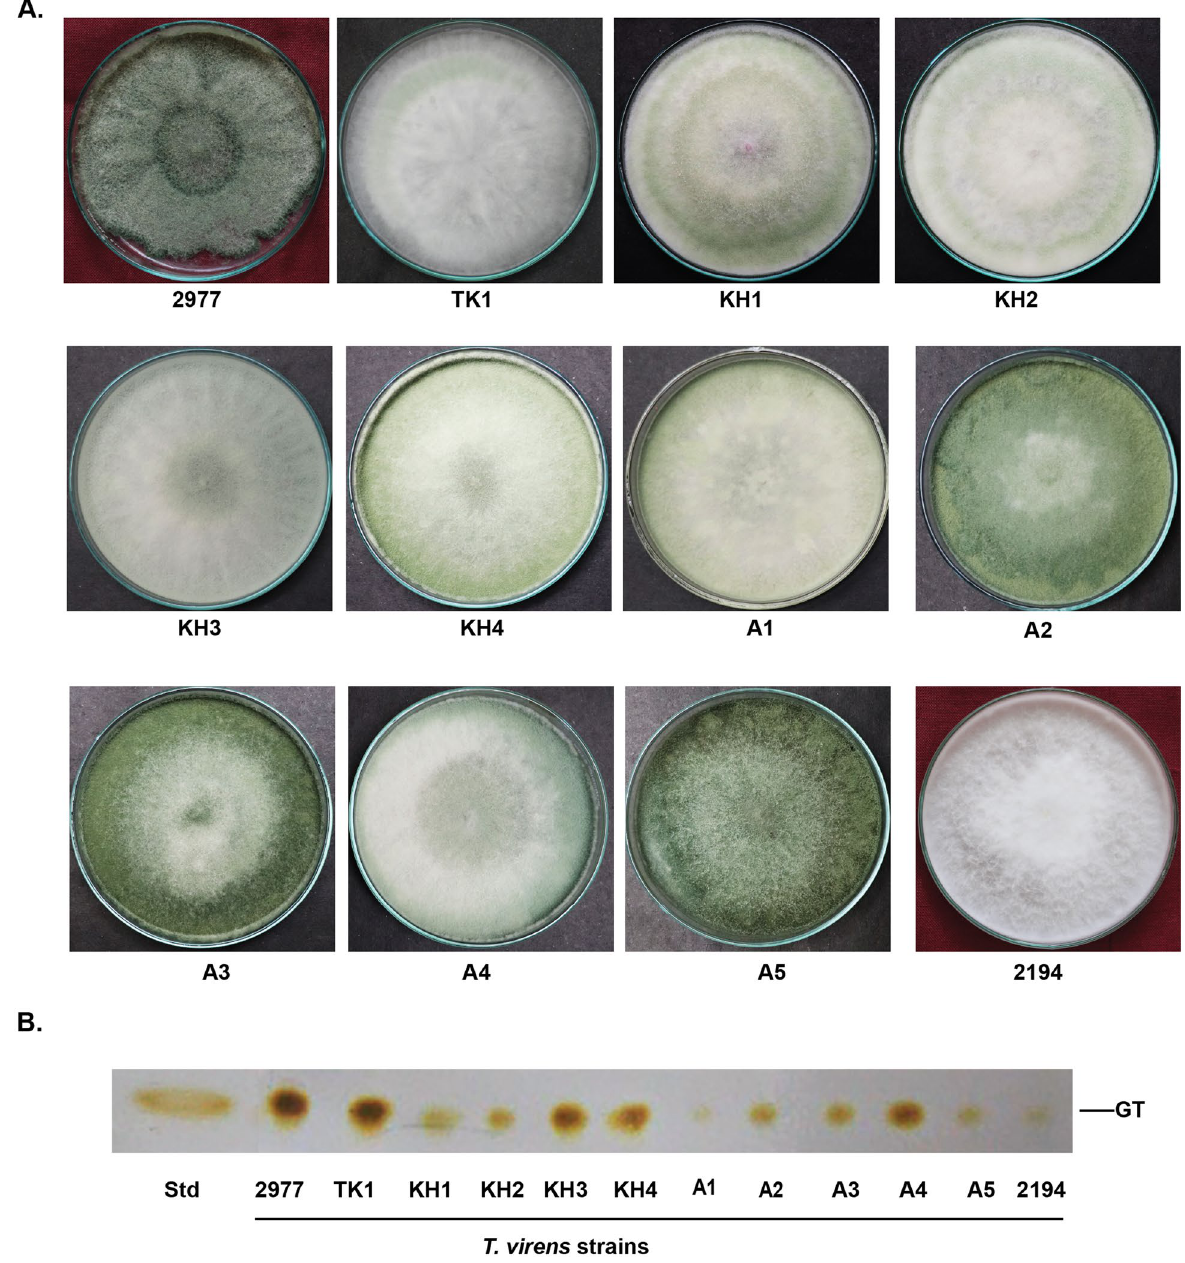
Figure 1. Isolation of gliotoxin producing T. virens strains from soil. ( A ) Gliotoxin producing T. virens strains were isolated and cultured on PDA medium. ( B ) Analysis of gliotoxin production by T. virens strains using TLC. Four days old culture filtrates were extracted with chloroform. Extracts were spotted on TLC plates and sprayed with silver nitrate. Presence of brown colour band indicates the gliotoxin. GT gliotoxin, Std standard